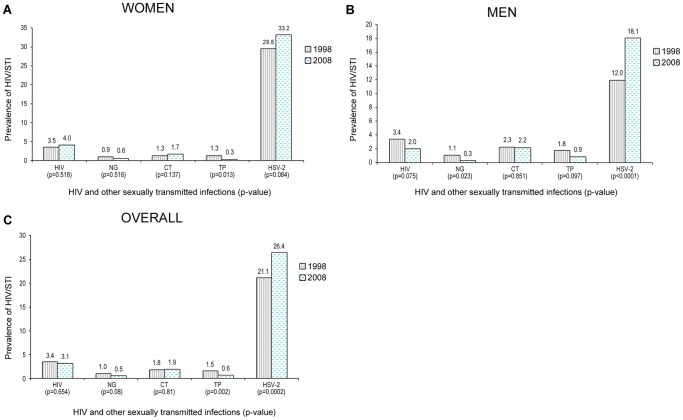
Univariate comparison of HIV/STI prevalence between 1998 and 2008 among women, Men and Overall, aged 15–49 years, general population of Cotonou, Benin.P-values are from Roa-Scott chi-square tests (chi-square tests adjusted for the cluster effect). NG, Neisseria gonorrhoeae; CT, Chlamydia trachomatis; TP, Treponema pallidum; HSV-2, Herpes simplex virus type-2.